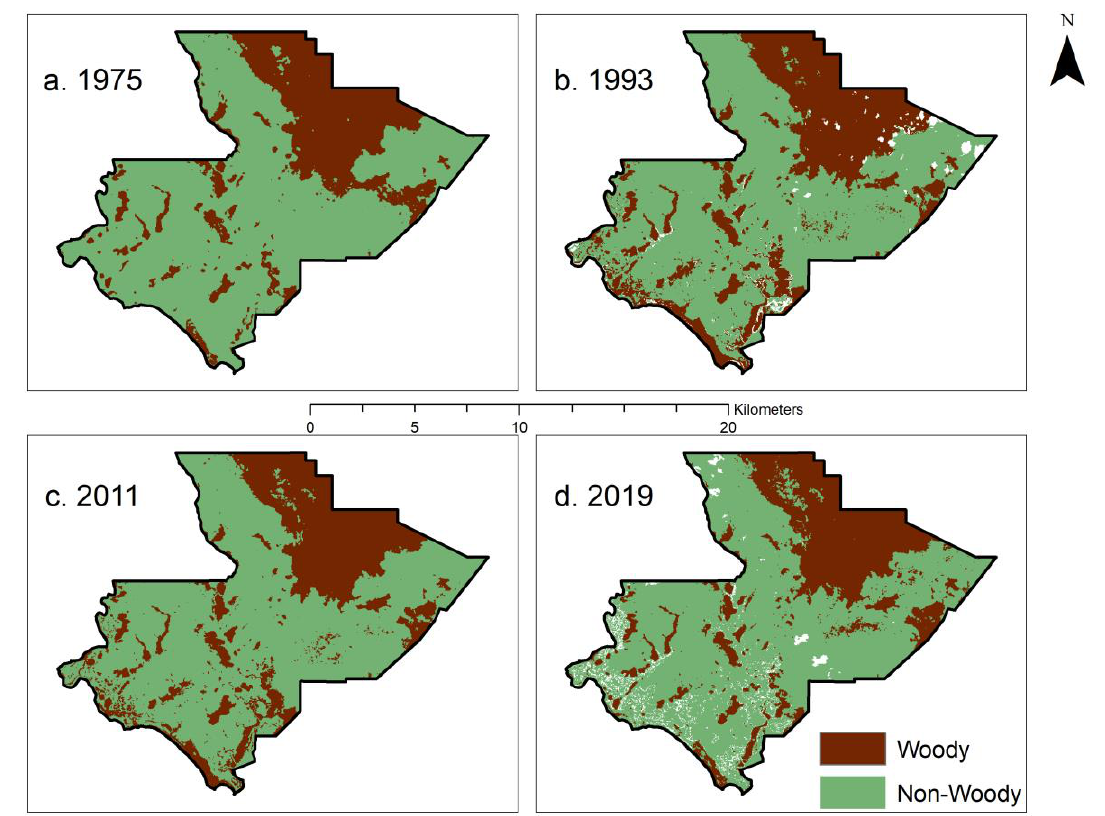
Figure 5. Maps showing the SVM land cover classification after reclassifying pixels as “Woody” or “Non-Woody”: ( a ) 1975; ( b ) 1993; ( c ) 2011; ( d ) 2019. White pixels represent cloud and cloud shadow, which were reclassified as no data.